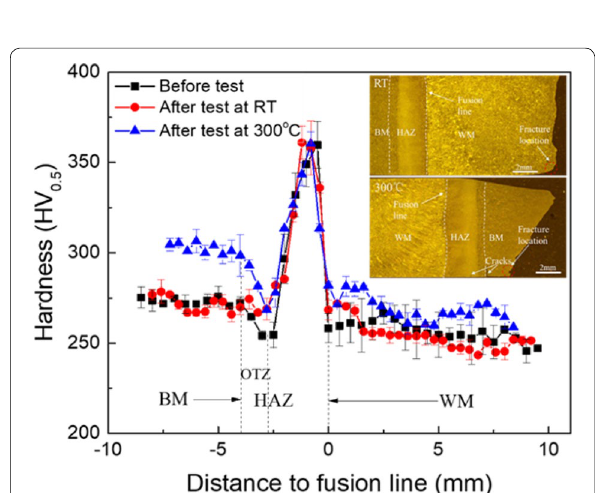
Figure 6 Failure location and micro-hardness distribution before and after